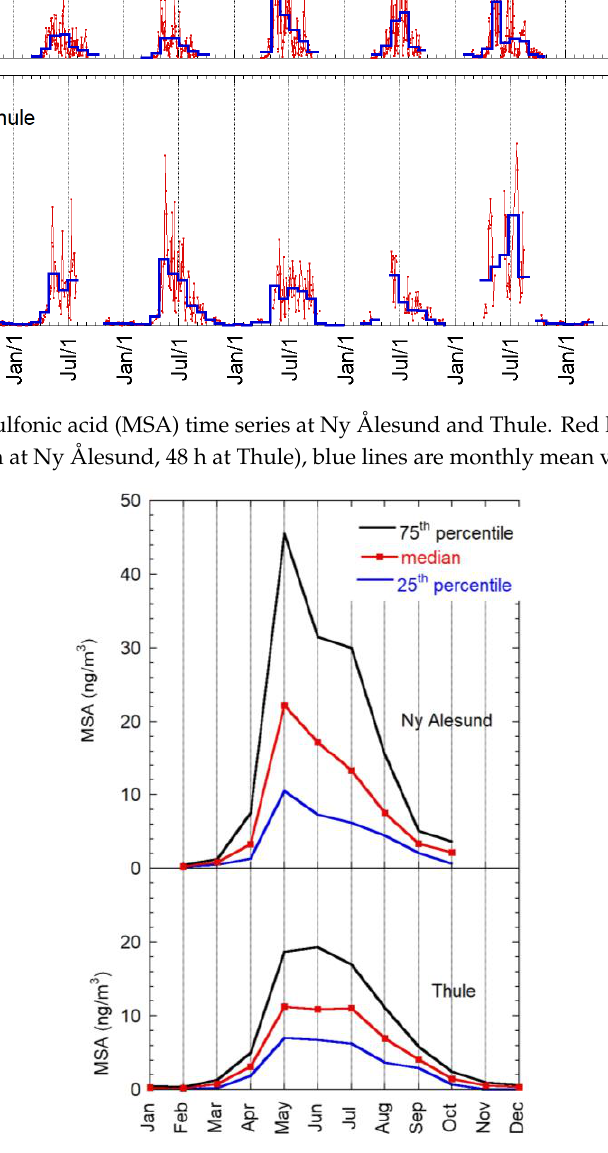
Figure 3. MSA median seasonal pattern at Ny Ålesund and Thule. Red lines represent median values, blue and black lines represent 25th and 75th percentiles, respectively.